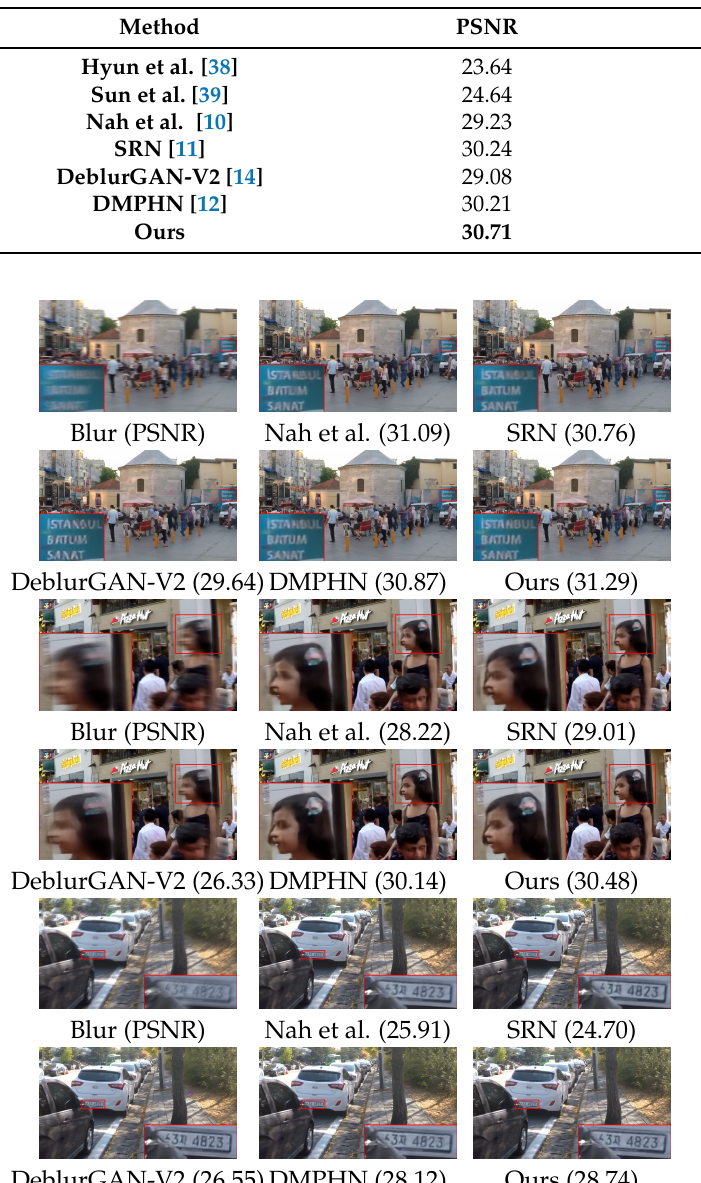
Figure 5. Visual comparisons with state-of-the-art methods on example synthetic blurry images. Quantitative metric PSNR is reported below each